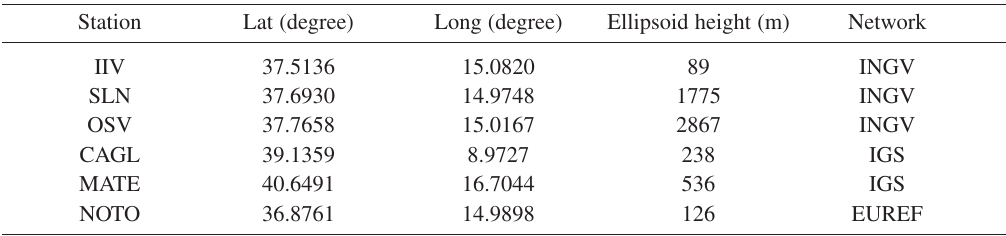
Table I. GPS stations used in this work. Columns from left to right respectively display station name, latitude, longitude, ellipsoid height and the network to which the station belongs (INGV = Istituto Nazionale di Geofisi-